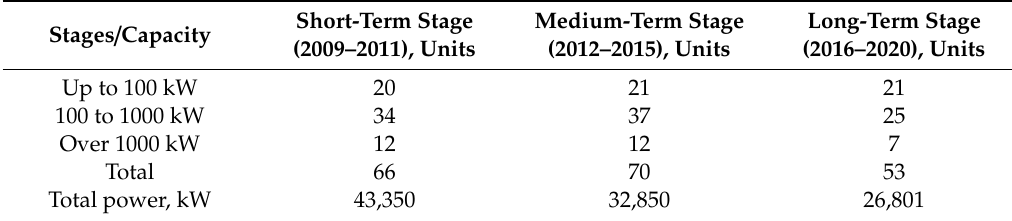
Table 1. The prospect of SHPP building according to the program.